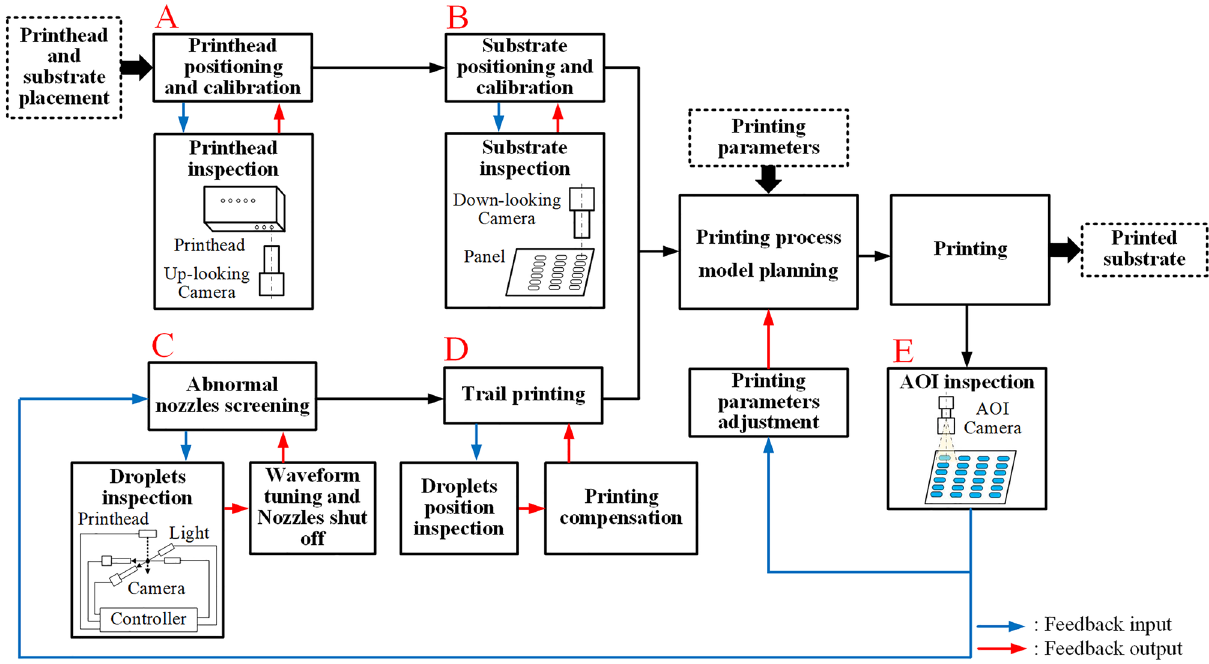
Figure 5. Simplified diagram of the closed-loop feedback system in the printing